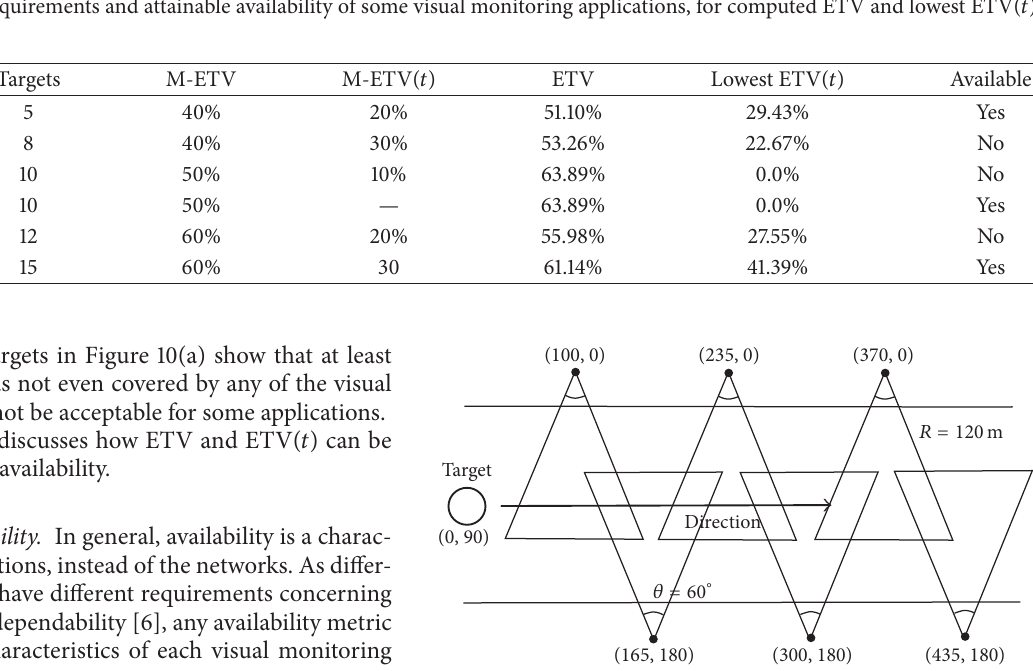
Figure 11: Monitoring scenario for a road with moving cars.